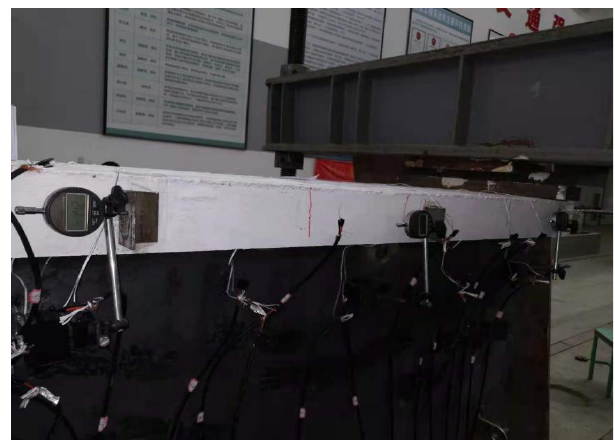
Figure 7. Real Fixing Method of Dial Gauge.